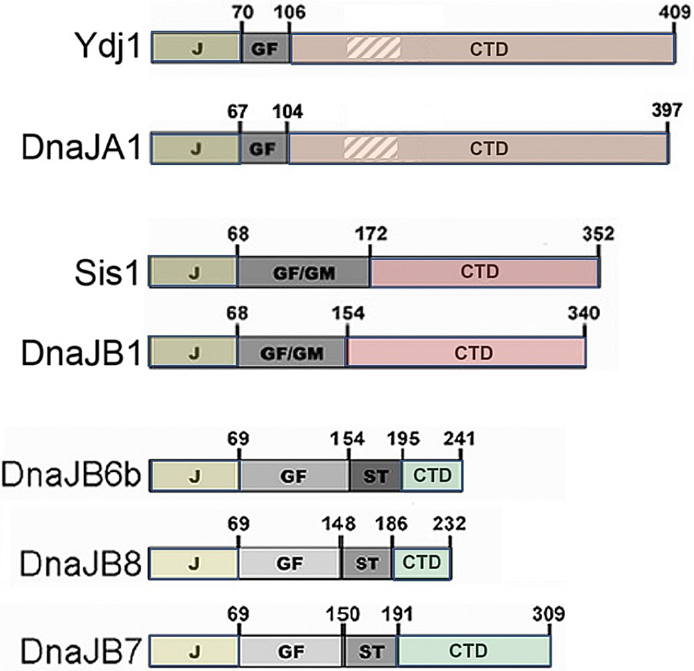
Figure 1. Domain structures of yeast (Ydj1 and Sis1) and related human JDPs. DnaJA1 (class A) and DnaJB1 (class B) are the closest human relatives of Ydj1 and Sis1, respectively. Numbers indicate amino acid positions at domain borders. The roughly 70 amino acid N-terminal J domains bind Hsp70, GF and GM regions confer some specificity of function, and the CTDs bind substrates. Class A JDPs Ydj1, and DnaJA1 also encode a zinc-binding region (hatched) embedded in the CTD. DnaJB6b, JB7, and JB8 comprise a class B subclass. Each has an amyloid-binding S/T region and a shorter CTD.